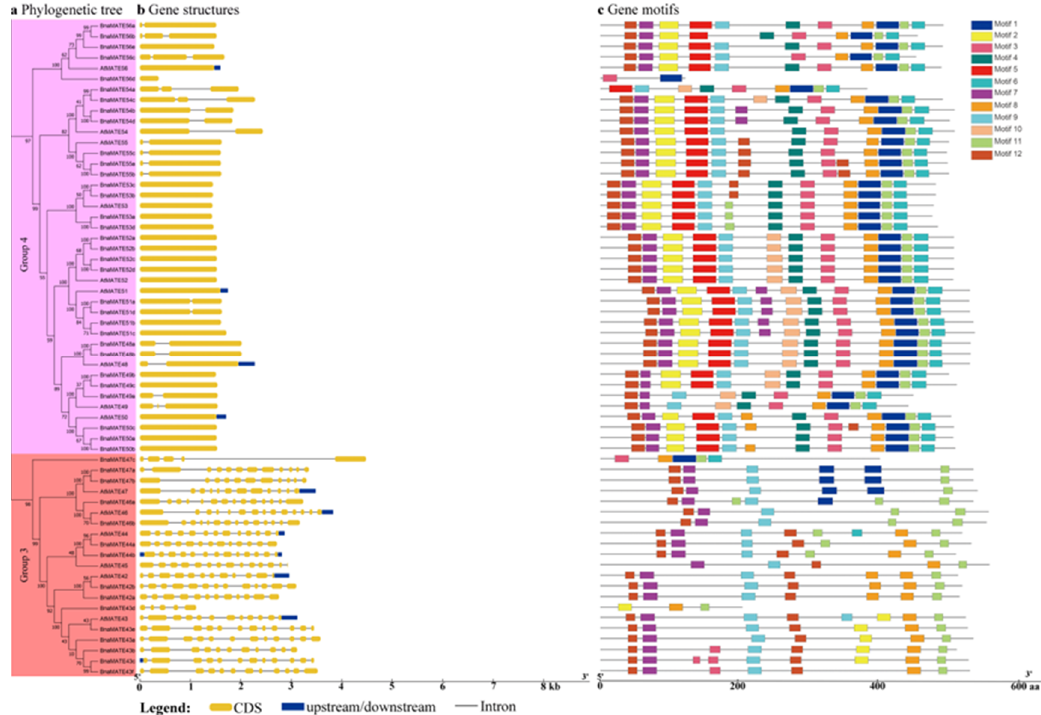
Figure 4. Gene structure and conserved motifs in MATE genes from Brassica napus and Arabidopsis thaliana. ( a ) The neighbor-joining tree was generated from the alignment of 181 MATE genes from A. thaliana and B. napus . The different background colors represent the four subgroups. ( b ) Gene structures were generated using the Gene Structure Display Server (GSDS 2.0) [42]. Yellow boxes indicate exons, black lines indicate introns, and blue boxes indicate untranslated regions (UTRs) of genes. ( c ) Conserved motifs were detected using MEME and are shown as boxes of different colors (numbered as motifs 1–12).